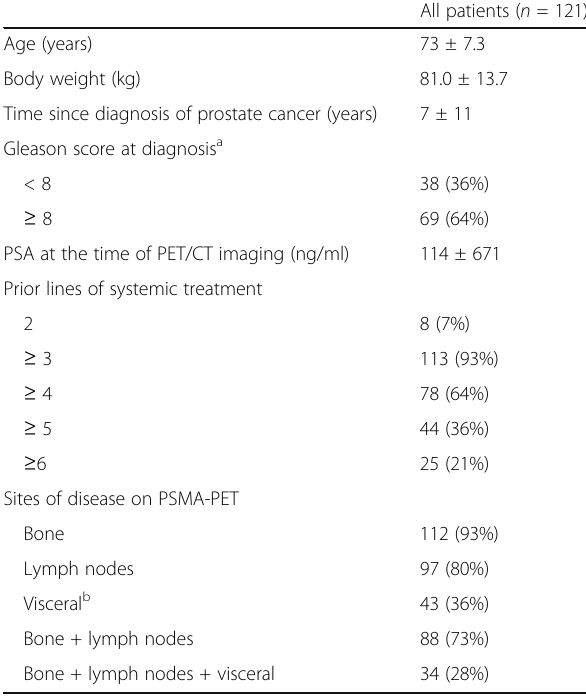
Table 1 Patients characteristics